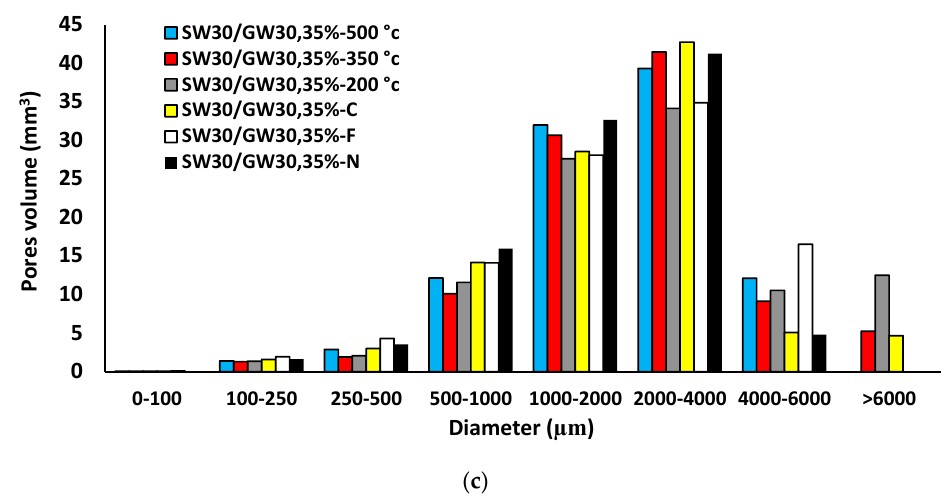
Figure 18. Porous structure characteristics of SW30/GW30-2% Fiber-35% Foam after exposure to different testing conditions: ( a ) total porosity; ( b ) numbers of pores; ( c ) pore volume.